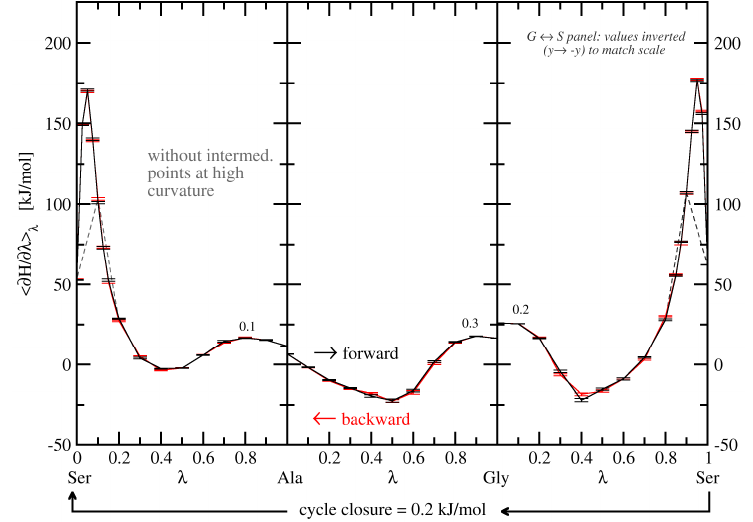
Figure 3. Final thermodynamic cycle in H 2 O, at 10 ns simulation time per λ -point for all TI curves. Solid black lines are forward transformations (read from left to right), solid red lines are backward transformations (read from right to left; shown with inverted sign and direction for better comparability to the forward process). Dashed lines are provided to highlight the necessity of additional λ -values at areas of high curvature. Note that for the G ↔ S transformations the negative value of ∂ H/ ∂λ λ is plotted to match the scale. Numbers directly above and below the lines refer to the hysteresis between associated forward and backward transformations in in kJ·mol − 1 . Table 1. Comparison of values for Δ G mutate and ΔΔ G bind , in kJ·mol − 1 .